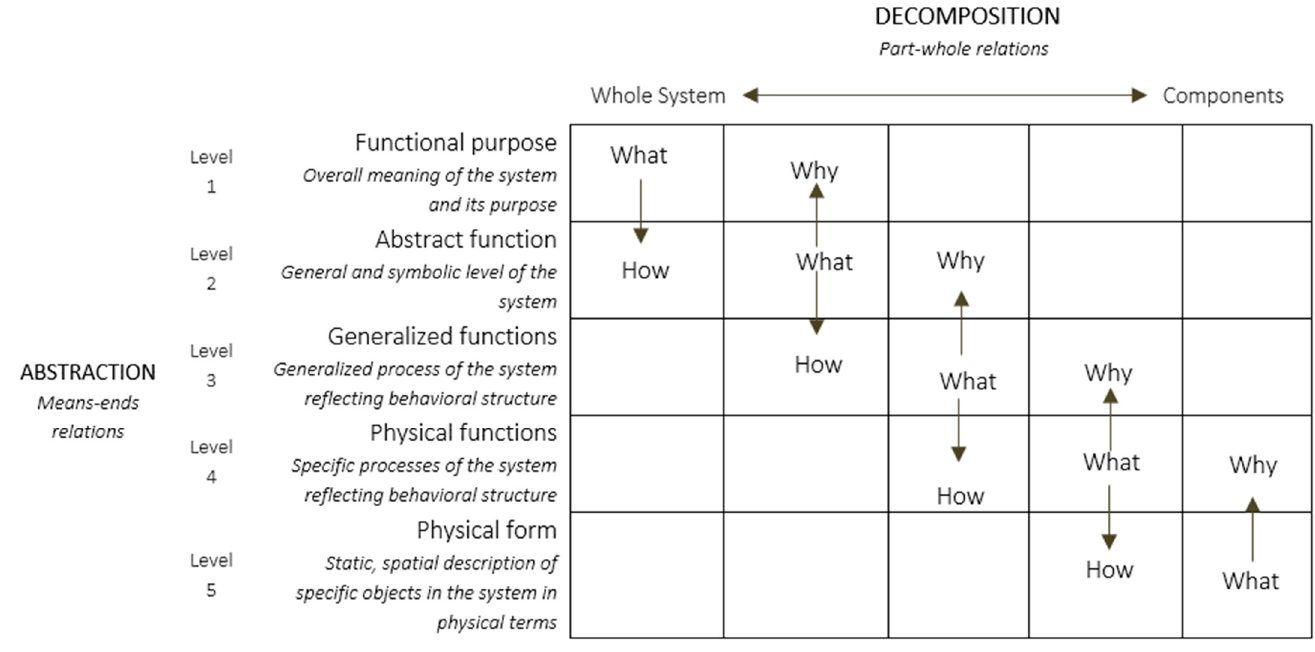
Figure 1. The abstraction–decomposition space.